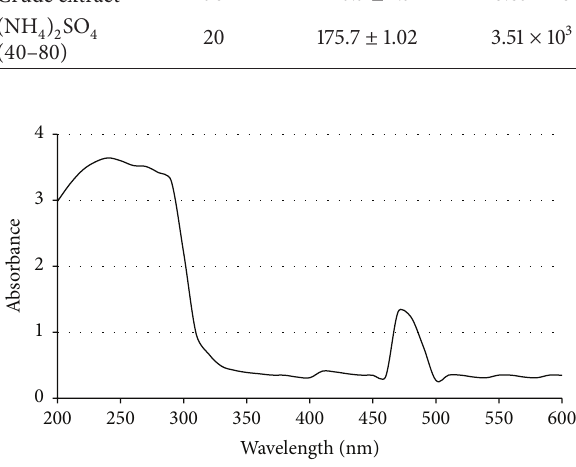
Figure 1: UV-vis spectra of silver nanoparticles.